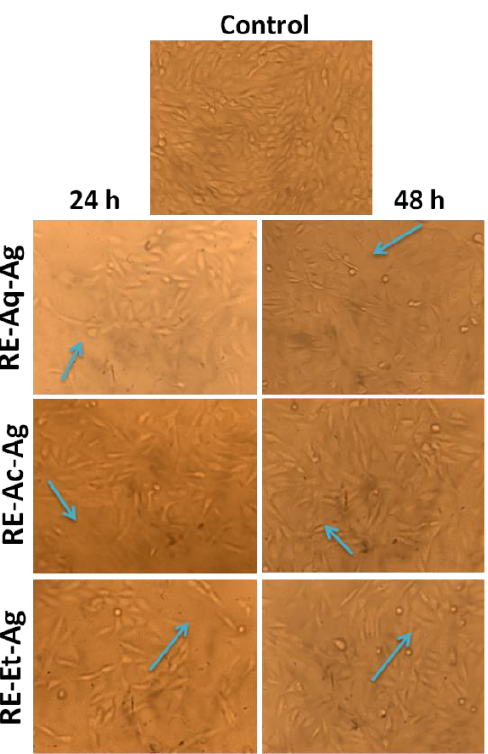
Figure 7. Optical microscopic images MG63 cell lines treated with RE-Ac-Ag, RE-Et-Ag, and RE- Aq-Ag.